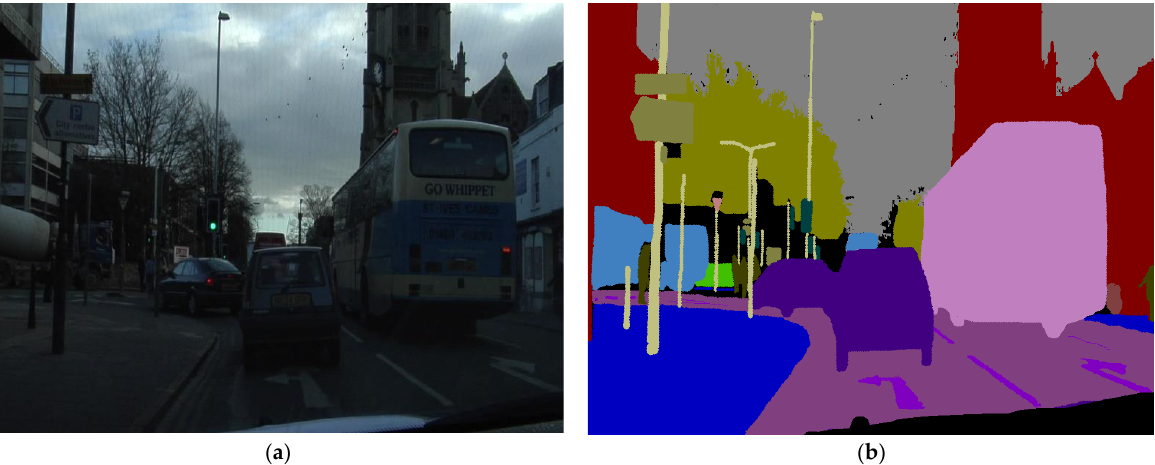
Figure 1. Semantic Segmentation Demonstration ( a ) Actual Image ( b ) Semantic Segmentation Ground-truth.